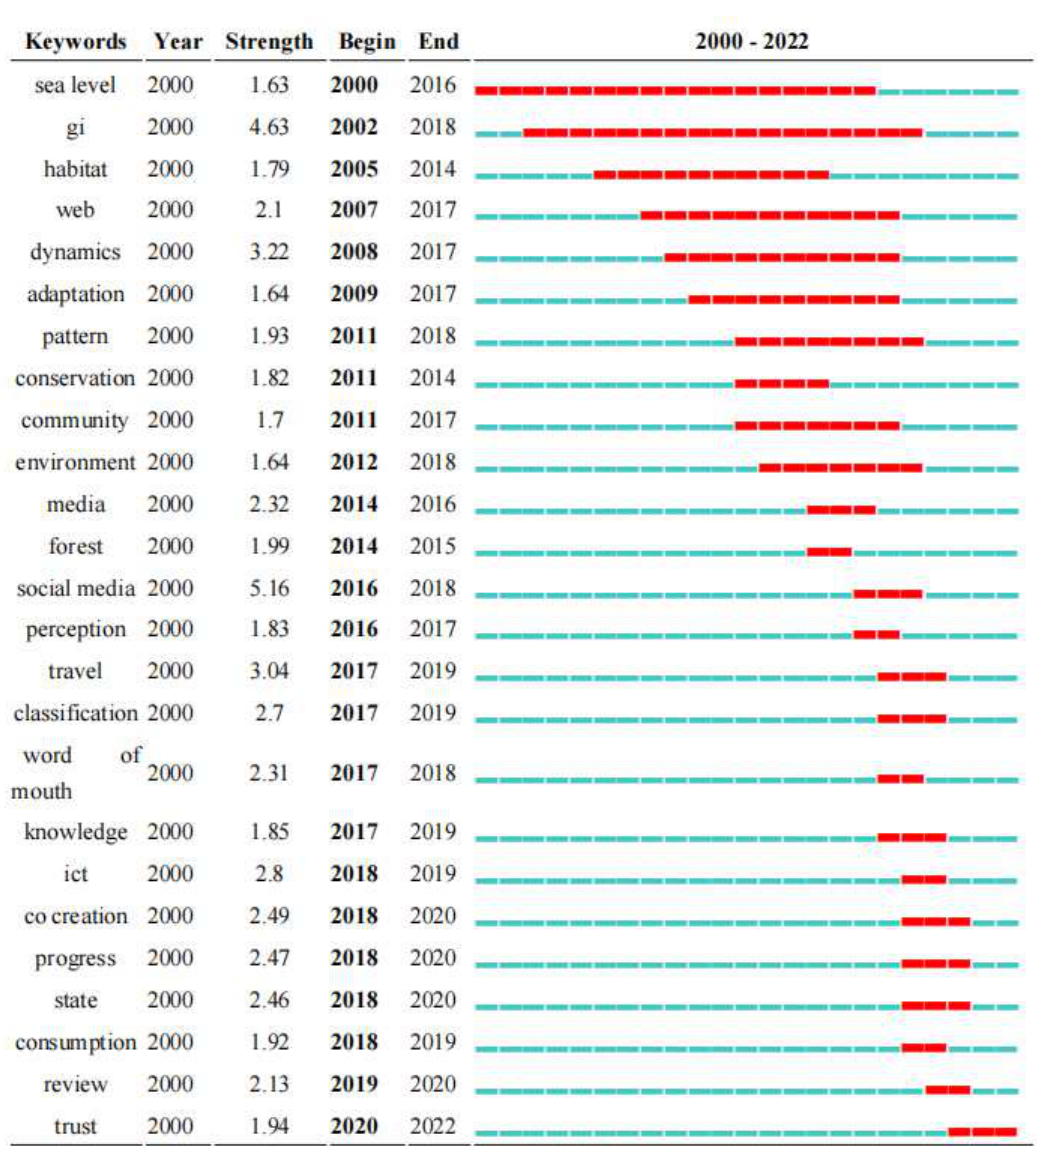
Figure 7. Top 25 keywords with the strongest citation